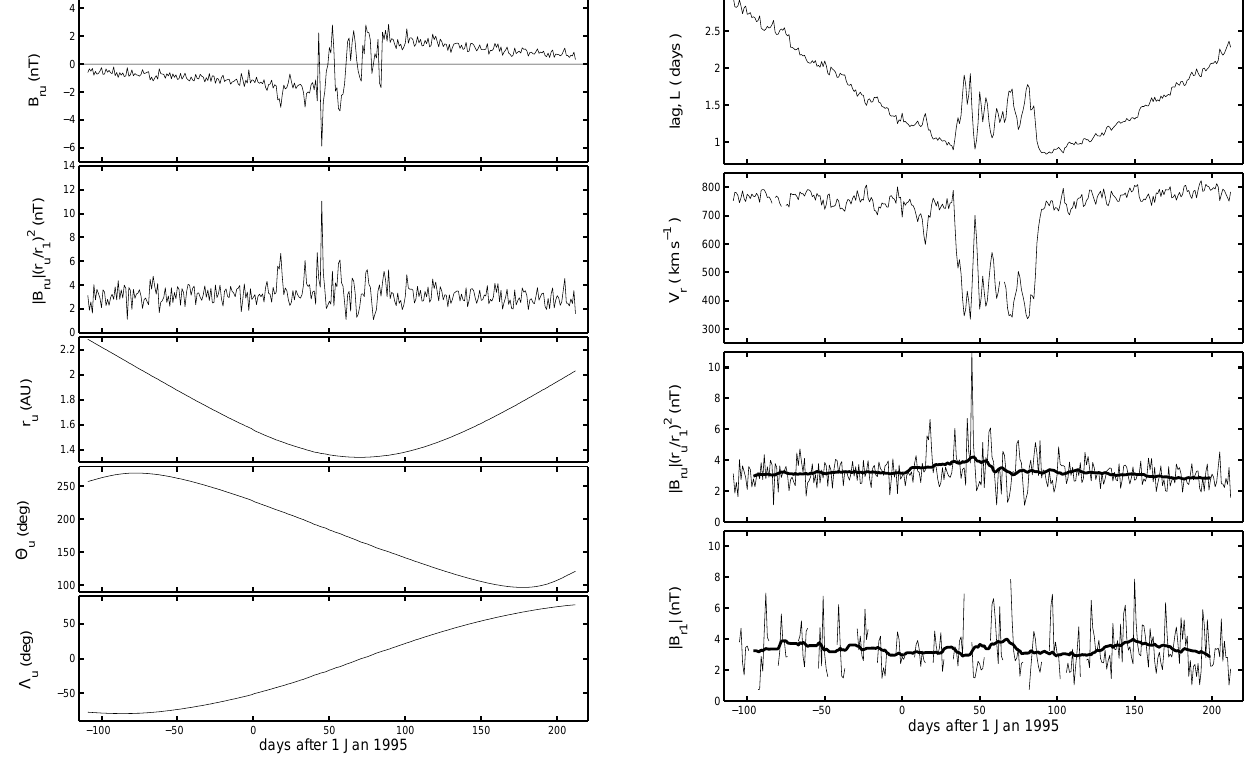
Fig. 5. Ulysses data from the first perihelion pass. From top to bot- tom: the radial component of the magnetic field seen by Ulysses B ru at radial heliocentric distance r = r u ; the absolute value of B ru , normalised to r = r 1 = 1AU using an r 2 dependence, | B ru | (r u /r 1 ) 2 ; the geocentric radial co-ordinate of the spacecraft r u ; the solar lon- gitude of the spacecraft 2 u (where 2 u = 0 along the Sun-Earth line); and the heliographic latitude of the craft, 3 u .